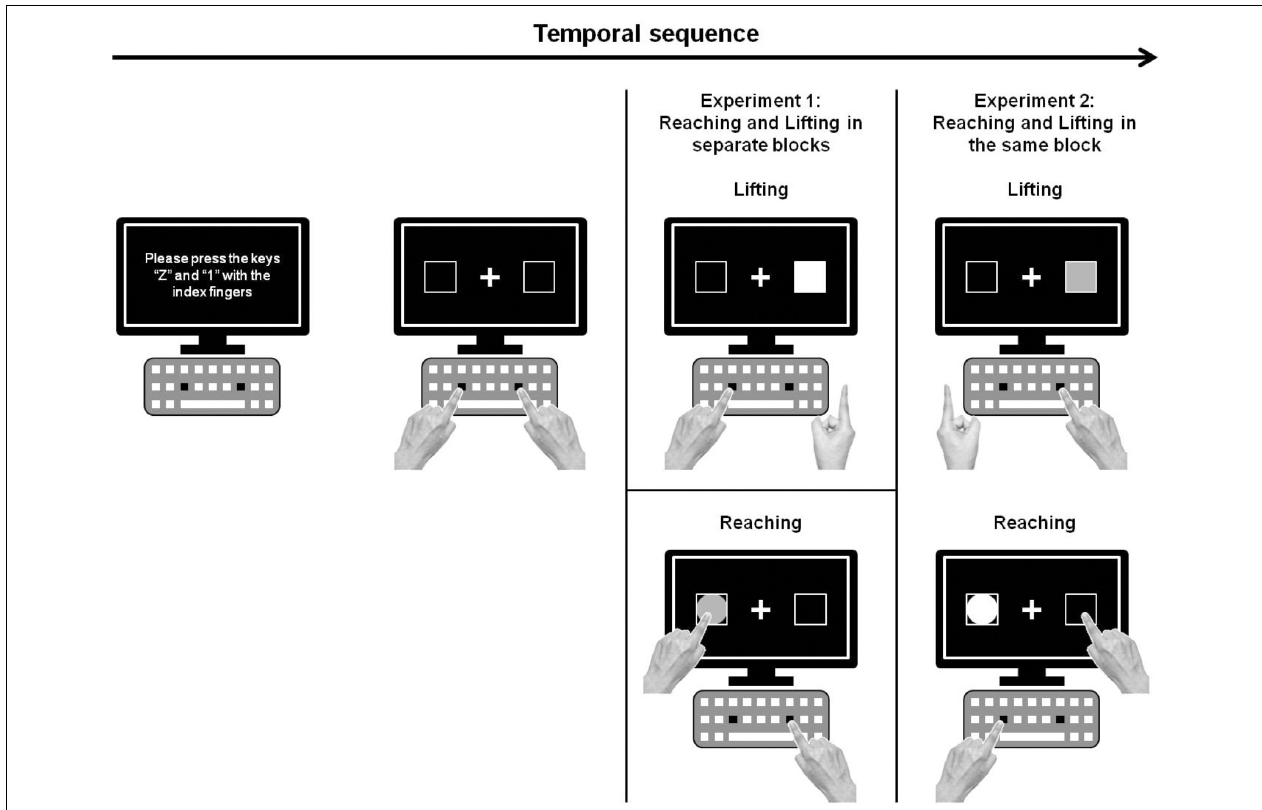
FIGURE 1 | Schematic drawing of the experimental set up and procedure of Experiments 1 and 2 (green stimuli are presented as white, and red stimuli, as